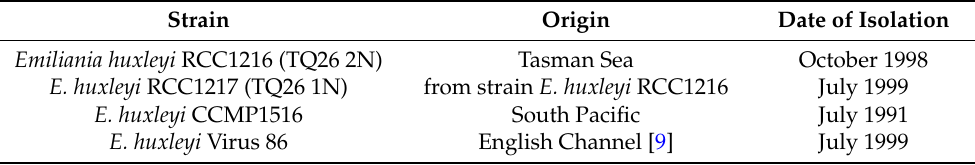
Table 1. Host and virus strains used in the current